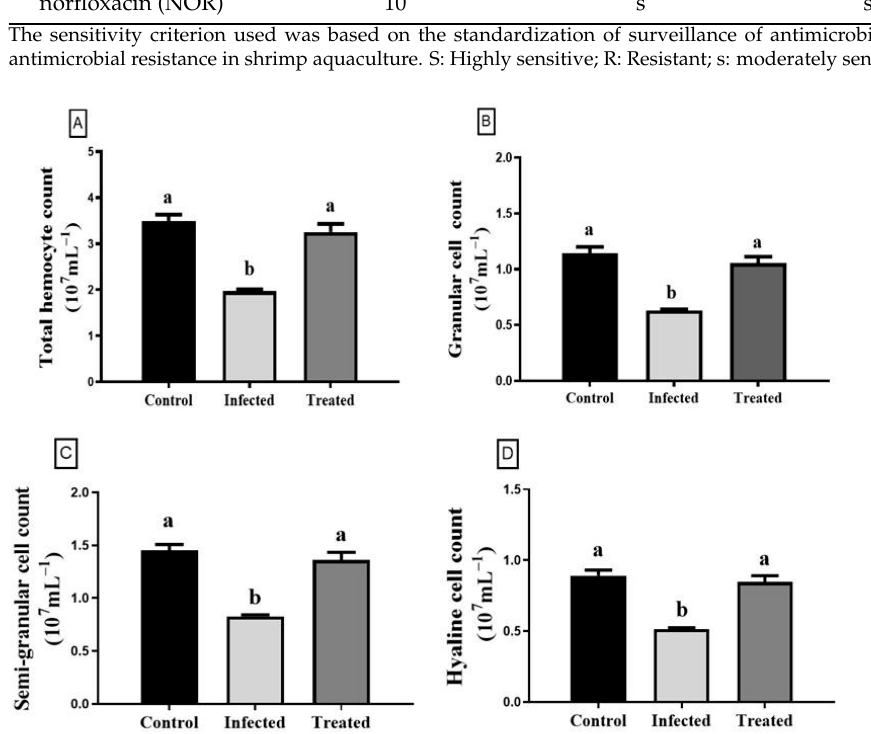
Figure 5. Total hemocyte count (THC; ( A )), granular cell (GC; ( B )), semi-granular cell (SGC; ( C )), and hyaline cell (HC; ( D )) of infected Litopenaeus vannamei with Vibrio spp. and those treated with florfenicol antibiotic. Values are expressed as the mean ± SME (n = 6 per group). Means with different superscripts are significantly different ( p < 0.05).